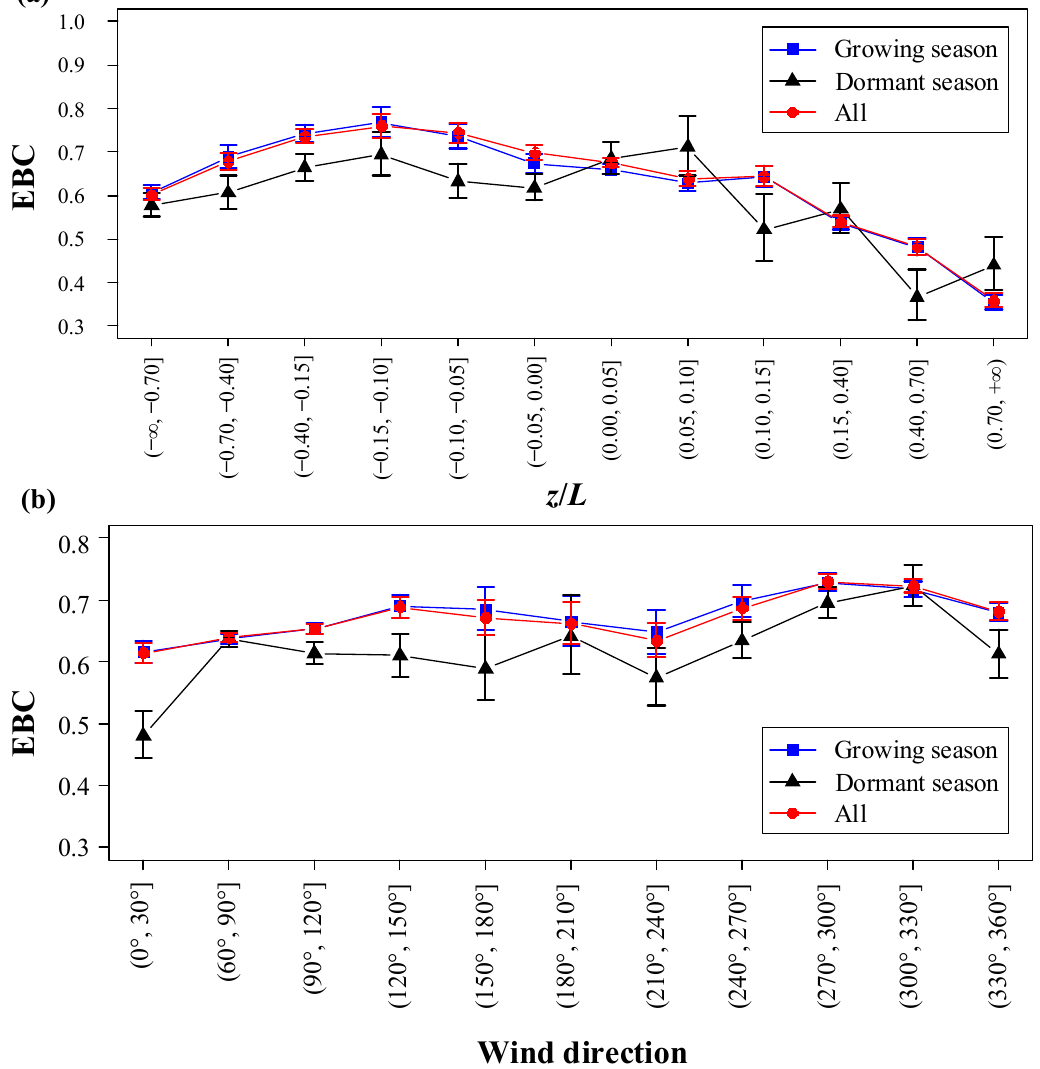
Figure 12. Average EBC for each bin of ( a ) atmospheric stability ( z/L ) and ( b ) wind direction. Average values of EBC are plotted for different wind directions (Figure 12b) to show how the surrounding terrain affects the EC measurements. During both the growing season and dormant season, EBC values were lowest in the bin (0 ◦ , 30 ◦ ]. EBC values during the growing season were highest in the bin (270 ◦ , 300 ◦ ], whereas during the dormant season EBC values were highest in the bin (300 ◦ , 330 ◦ ]. During the dormant season, EBC varied substantially more with wind direction than during the growing season. This suggests that the source area of the flux measurement may be an important cause of interseasonal differences in EBC at this